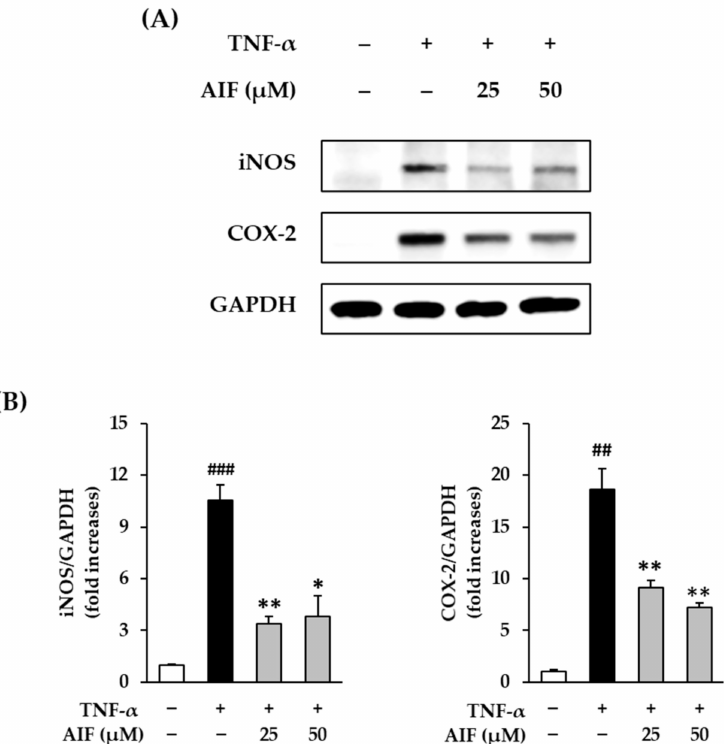
Figure 4. Inhibition of cyclooxygenase-2 (COX-2) and inducible nitric oxide synthase (iNOS) protein expression by alpinumisoflavone (AIF) in tumor necrosis factor- α (TNF- α )-treated human dermal fibroblasts (HDFs). ( A ) Expression of COX-2, iNOS, and glyceraldehyde 3-phosphate dehydrogenase (GAPDH) proteins. ( B ) Relative protein expression levels of COX-2 and iNOS. HDFs were challenged with 20 ng/mL TNF- α in the presence or absence of AIF (25 and 50 µ M) for 6 h. The protein expression was determined using Western blot analysis. The data are presented as mean ± SEM of at least three independent experiments. ## p < 0.01 and ### p < 0.001 as compared with the untreated cells. * p < 0.05 and ** p < 0.01 as compared with the TNF- α -treated